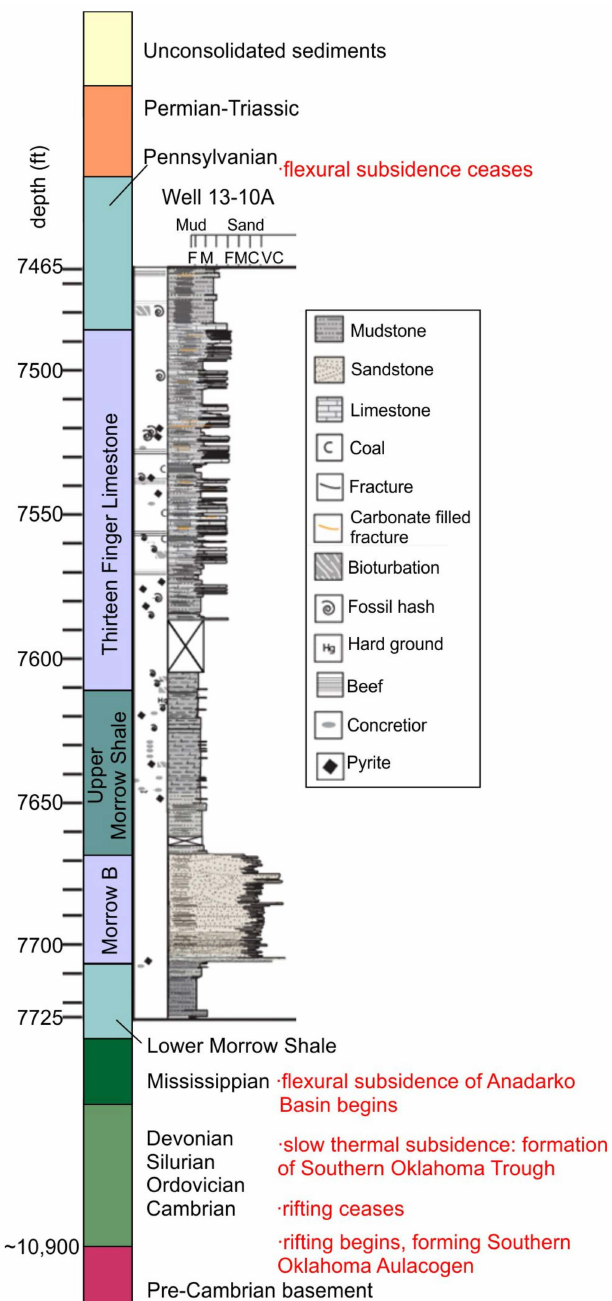
Figure 3. Simplified stratigraphic column of Farnsworth Field area, with details of CO 2 reservoir (Morrow B) and cap rock at well 13–10A (location of this well is shown in Figure 2), and major tectonic events (in red). Grain size: F is fine, M is medium, C is coarse, VC is very